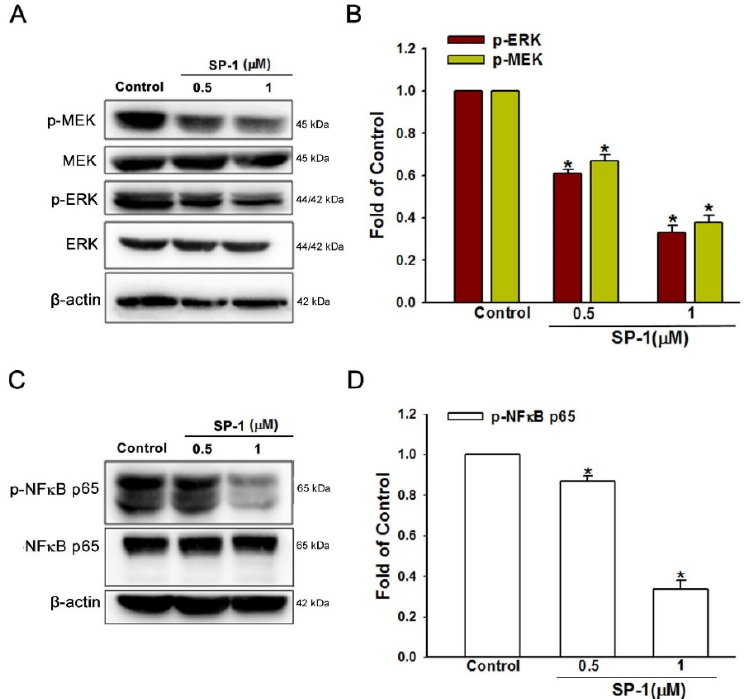
Figure 5. Heteronemin inhibited mitogen-activated protein kinase and transcription factors in human lymphatic endothelial cells. Cells were treated with the indicated concentrations of heteronemin (represented as SP-1); subsequently, the indicated ( A ) MEK/ERK and ( C ) p65 phosphorylated and total proteins were determined by Western blot analysis. The quantitative densitometry of phosphorylated ( B ) MEK/ERK and ( D ) p65 protein was performed with Image-Pro Plus. Data are expressed as mean ± SEM of five independent experiments. * p < 0.05, compared with the control group.